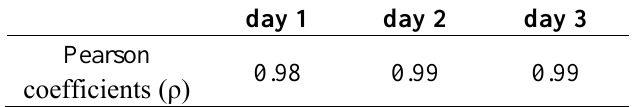
Table 2. Statistical analysis of N-content data: Pearson correlation coefficient